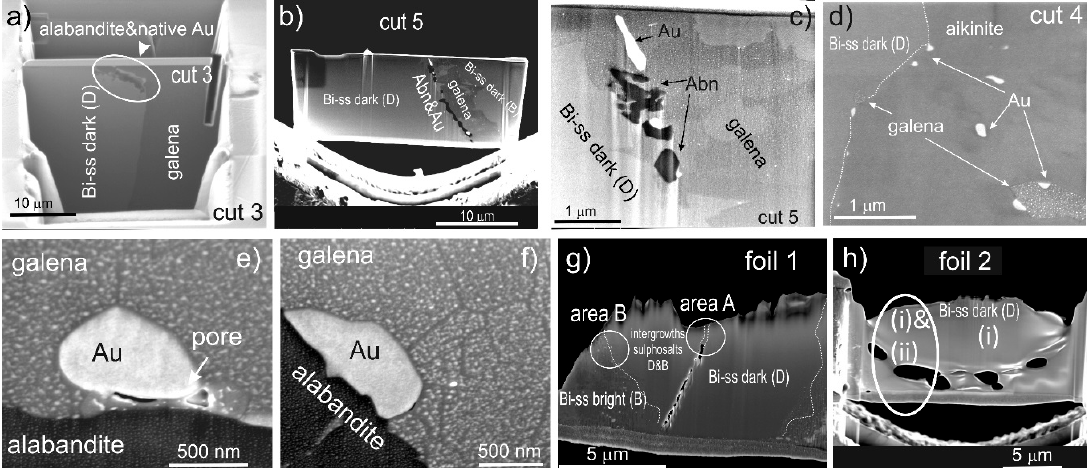
Figure 6. Secondary Electron images showing details of the FIB-cuts lifted and placed on Cu grids ( a – f ); and TEM images of foils 1 and 2 ( g – h ); Note the association between alabandite (Abn) and native gold (Au) along fractures ( a – b ) and trails ( c ); Abundant, finest grains of native gold in aikinite ( d ); Note their distribution at the contact between aikinite and dark Bi-ss; ( e , f ) Details of fine particles of native gold at the contact between galena and alabandite. See the text for additional explanation. Letters A, B in ( g ) and (i), (ii) in ( h ) define areas of interest discussed in the text.